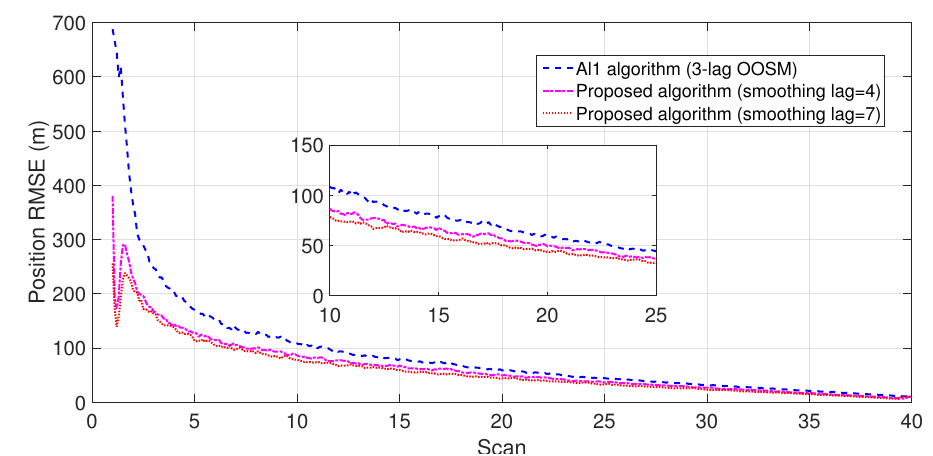
Figure 9. RMSE in position estimate for one-lag OOSM.